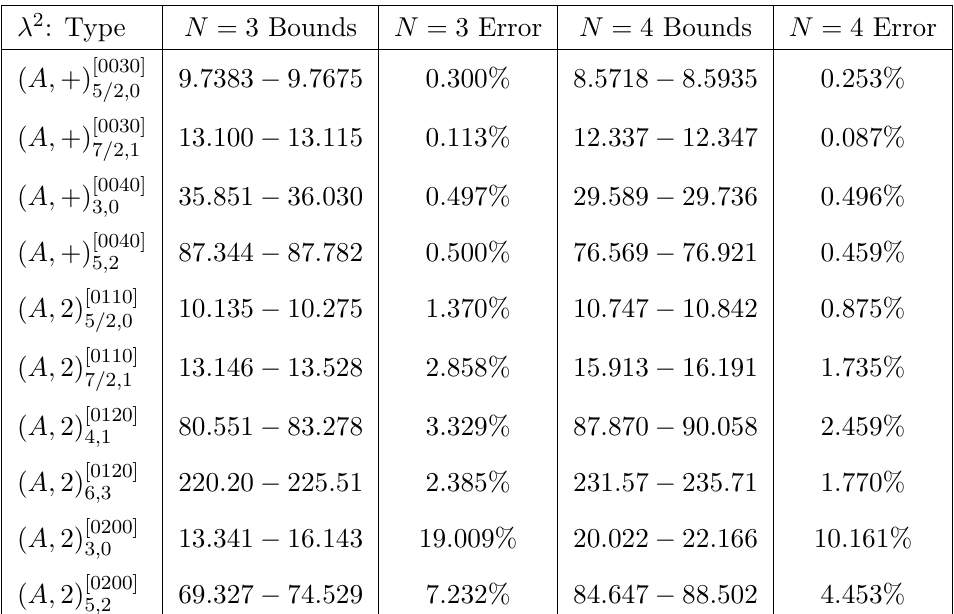
Table 9 . Upper and lower bounds on OPE coe(cid:14)cients squared for semishort operators, computed with (cid:3) = 35 using mixed correlators and the short OPE coe(cid:14)cients (cid:12)xed to their values for ABJM int and ABJM int using the 1d theory in section 4 ; 1